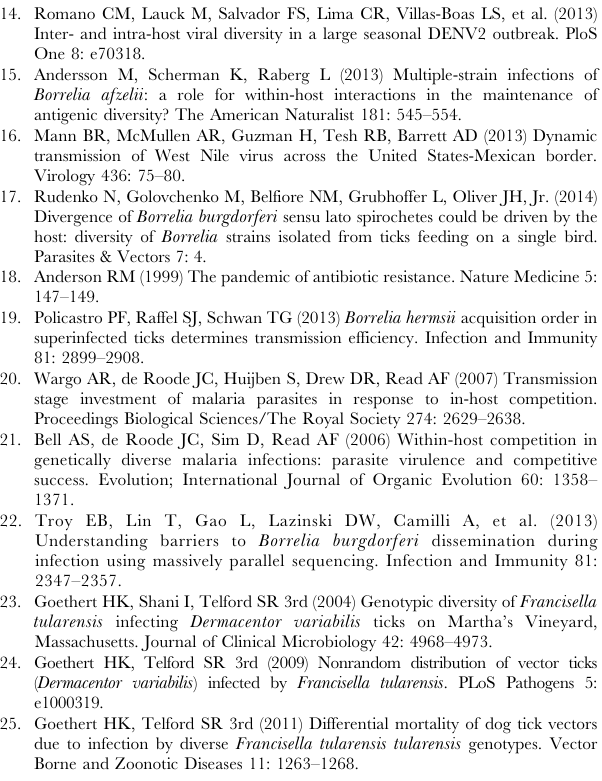
Table S1 F. novicida transposon mutants used in this study. Table S2 List of primers used in this study. Table S3 Parameters used in the standard runs of the model for vectors, hosts, and pathogens, and values used in the sensitivity analyses of vector-to-host ratios, vector and host abundance, and initial pathogen genotypic diversity. Table S4 List of genotypes, recovered from mice but not ticks in pooled genotype experiments, that were further investigated in single-infection assays and 1:1 competition assays with